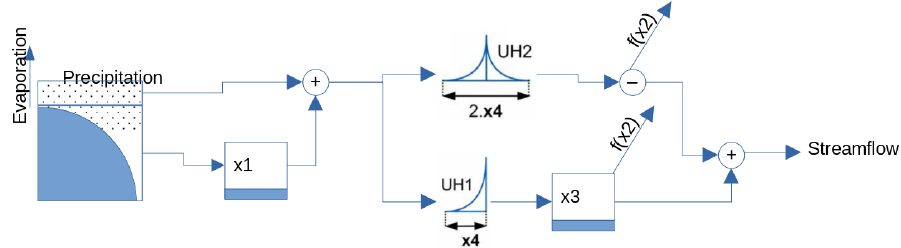
Figure 3. Schematic representation of the GR4J model.